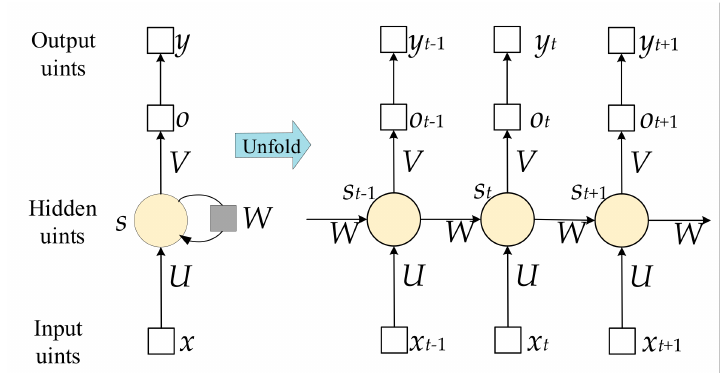
Figure 1. The structure of recurrent neural network